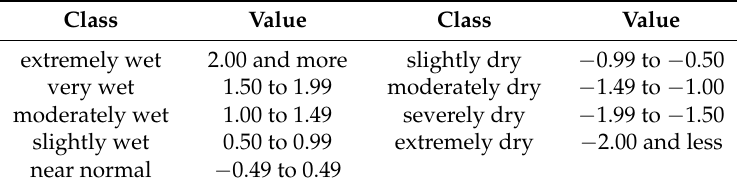
Table 1. Drought and wetter process classification according to SPI1 (one-month Standardized Precipitation Index)